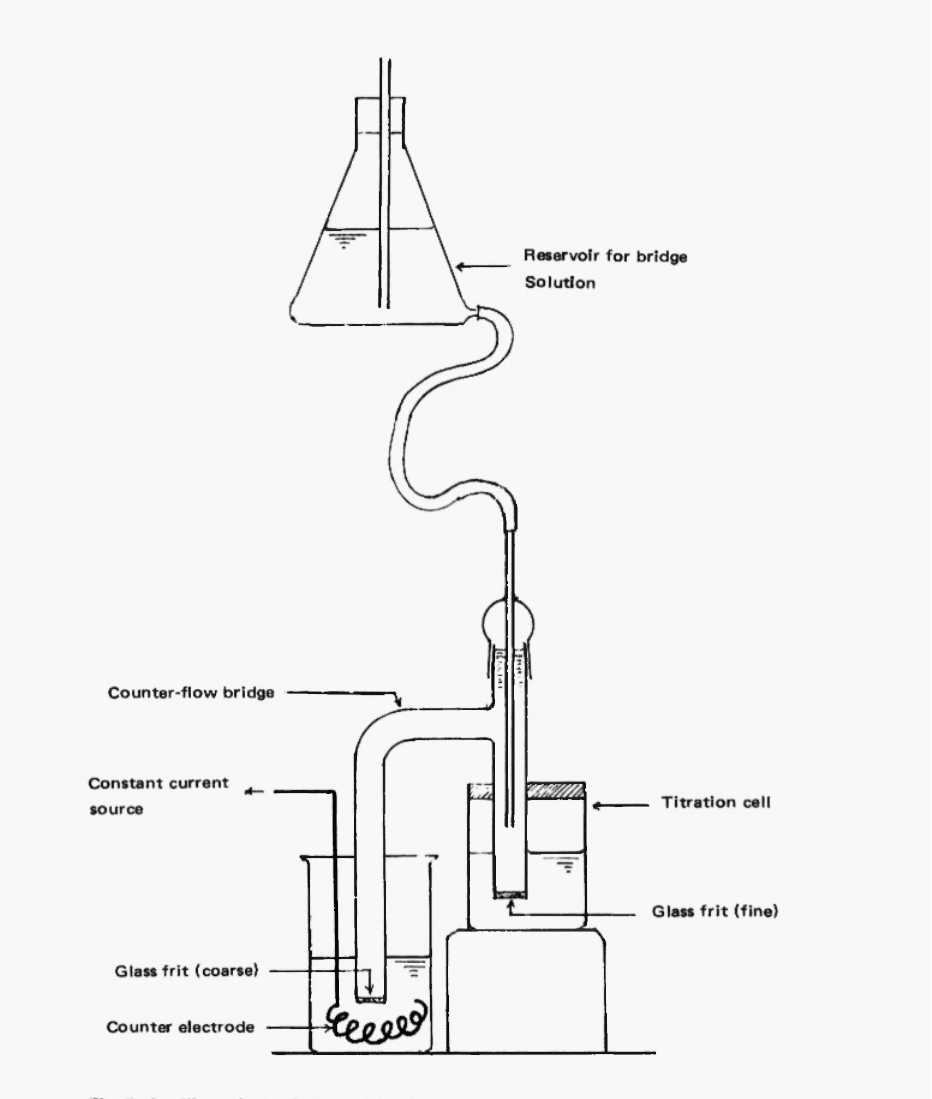
Fig. 2. Auxiliary electrode Assembly of counter-flow type by Eckfeldt and Shaffer /64/. Reprinted with permission from Eckfeldt, E.L., and Shaffer, E.W.,Jr. Anal. Chem., 37,1535 (1965). Copyright (19651 American Chemical Soci-